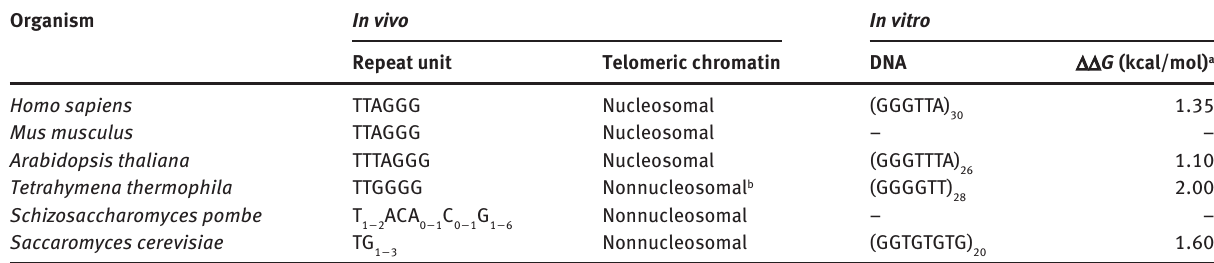
Table 1 Nucleosome organization in telomeric chromatin and comparative free energies for nucleosome formation in vitro.